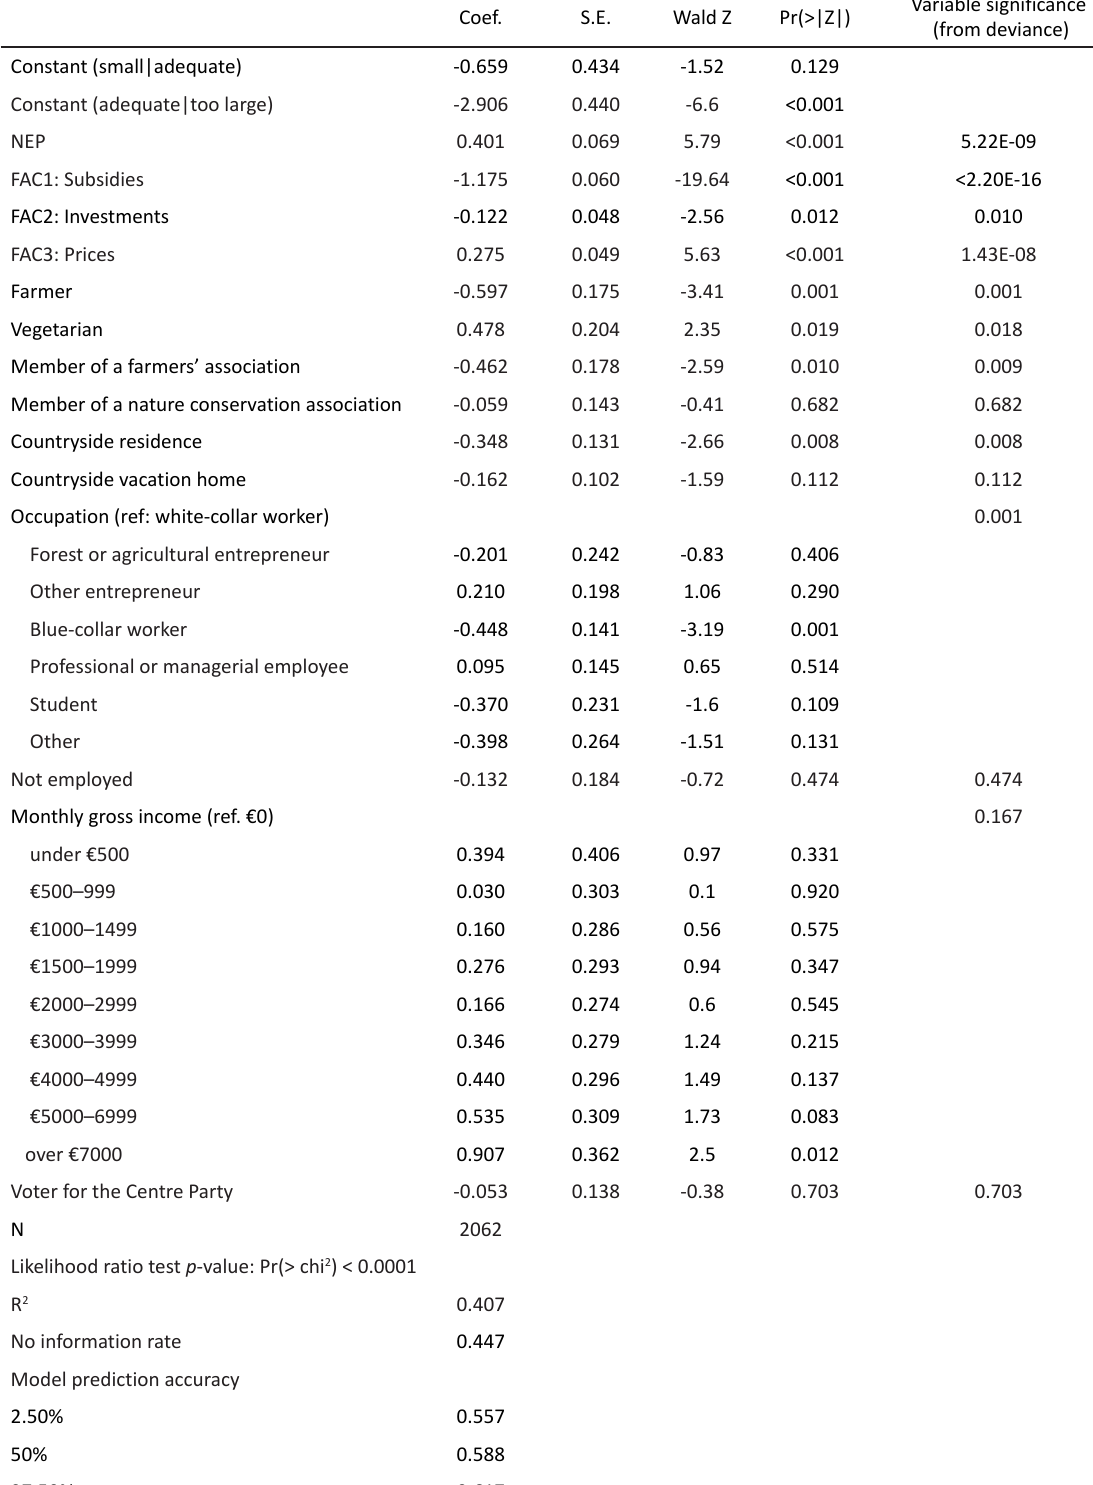
Table 7. Cumulative logit model for budget size (three classes: too small, adequate, too large) Coef.